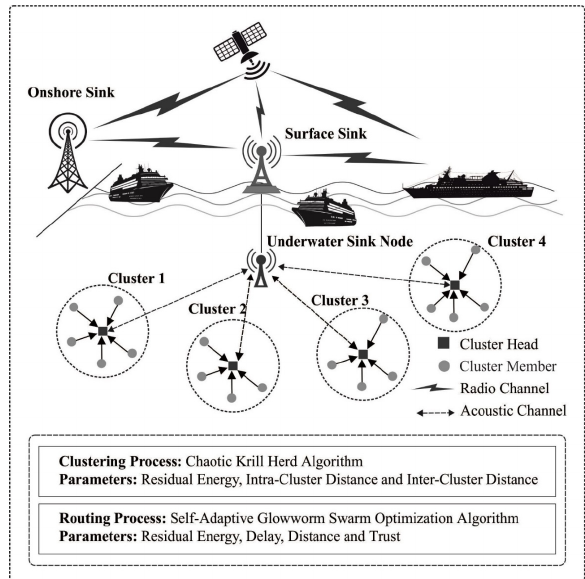
Figure 1. Overall process of the IMCMR-UWSN technique.